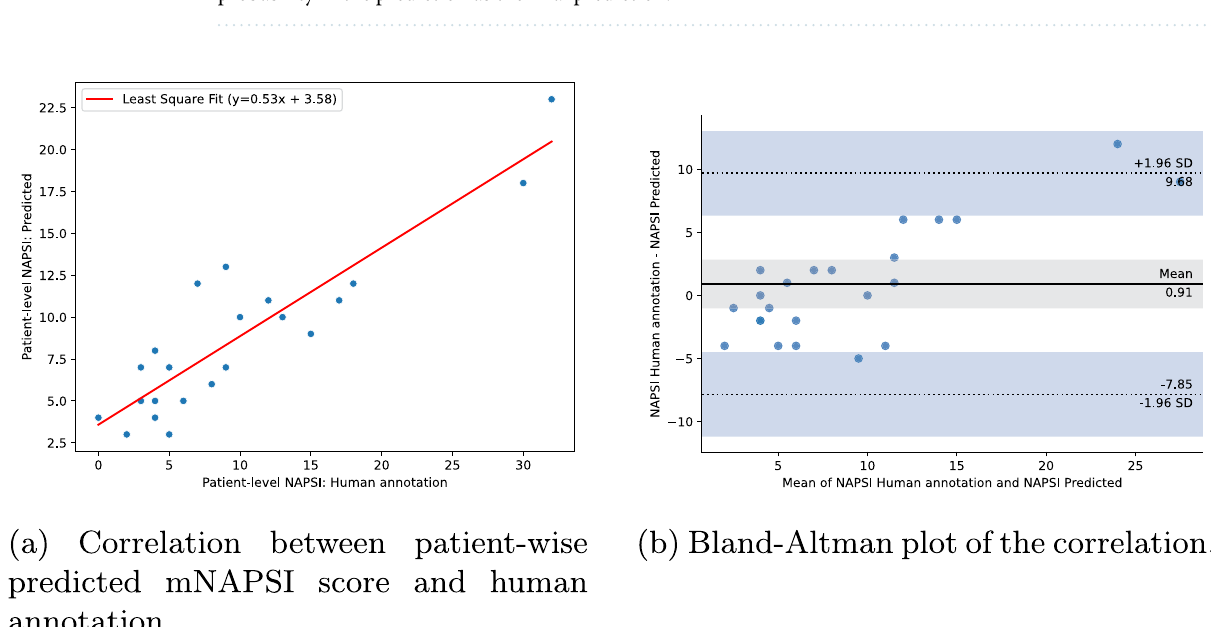
Figure 4. Confusion matrix of the ensemble of classification networks using the class with the highest probability in the prediction as the final prediction.